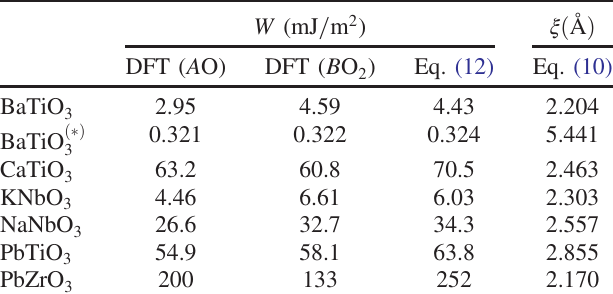
TABLE II. Domain-wall properties for six perovskite oxides: domain-wall energy W as computed using DFT (for the two possible A O and B O 2 domain walls) and as computed using the Landau model; and domain-wall thickness ξ as computed using the Landau